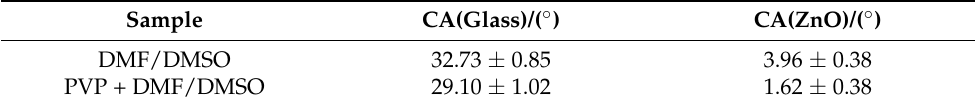
Table 1. Contact angle (CA) values for the solvent and polymer/solvent